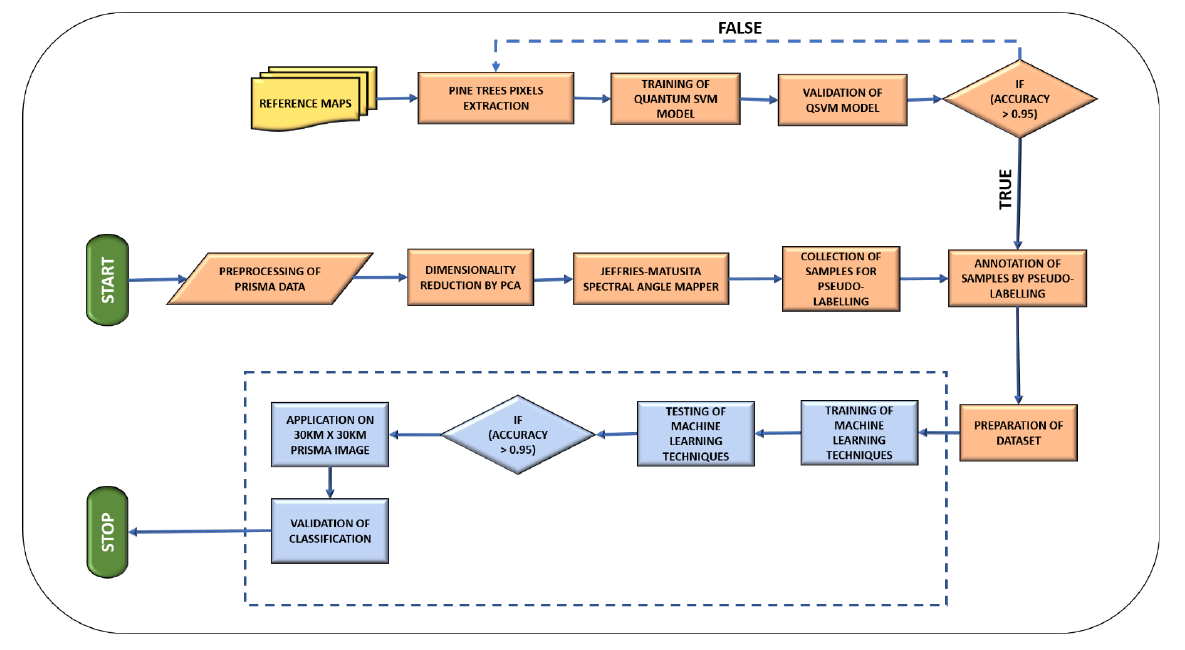
Figure 3. Flowchart of the quantum-based pseudo-labelling of samples.